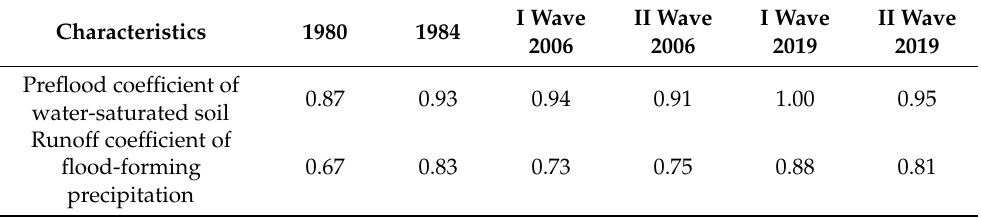
Table 6. The calculated values of the averaged-basin preflood coefficient of water-saturated soil and the runoff coefficient of flood-forming precipitation for the period of exceeding the critical water level threshold at Tulun gauge in 1980, 1984, 2006, and